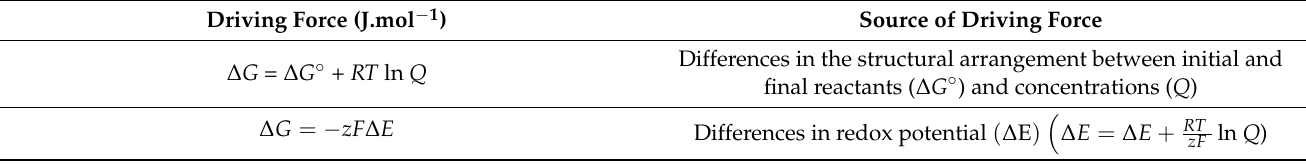
Table 1. Driving forces for biochemical reactions in living cells.